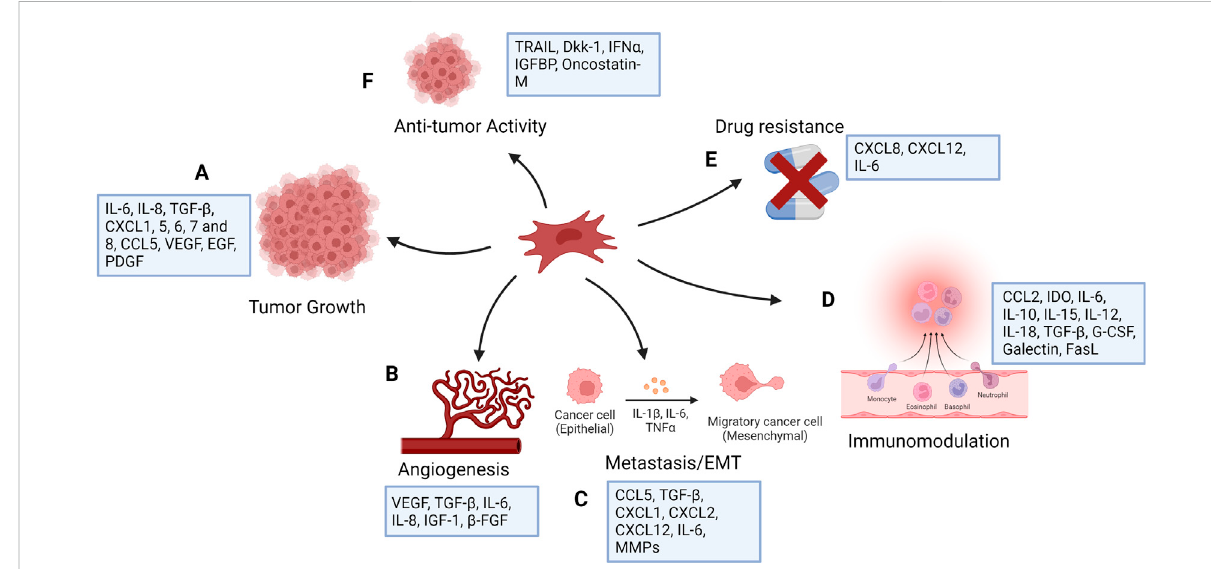
FIGURE 1 Functionsofmesenchymalstemcellsincancer(createdwithBioRender).MSCshavenumberofeffectsontumorcells,mostlyincreasingtumor growth as a result of their function in controlling in fl ammation and tissue repair. They affect tumor cell survival and stemness (A) and contribute to angiogenesis (B) by producing angiogenic factors. MSCs stimulate tumor cell motility, epithelial mesenchymal transition (EMT), and metastasis (C) , and secrete chemokines, including CXCL1, CXCL2, and CXCL12, and cytokines, including IL-6 and several matrix metalloproteinases (MMPs), whichdegradetheextracellularmatrixtofacilitatetumorcellmigration.Theyshowimmunomodulatoryfunction (D) andcaninducedrugresistance (E) . MSCs are generally pro-tumorigenic, however research has suggested that they may also have anti-tumor properties (F)